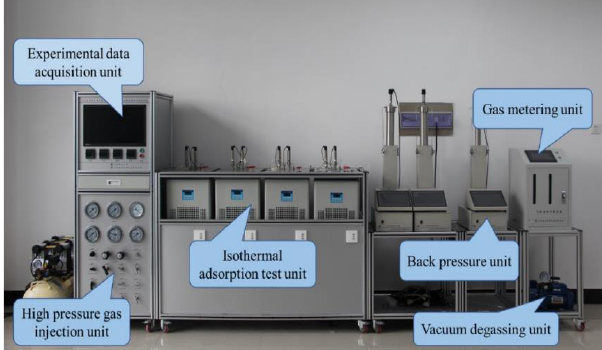
Figure 3. Schematic diagram of the experimental apparatus.